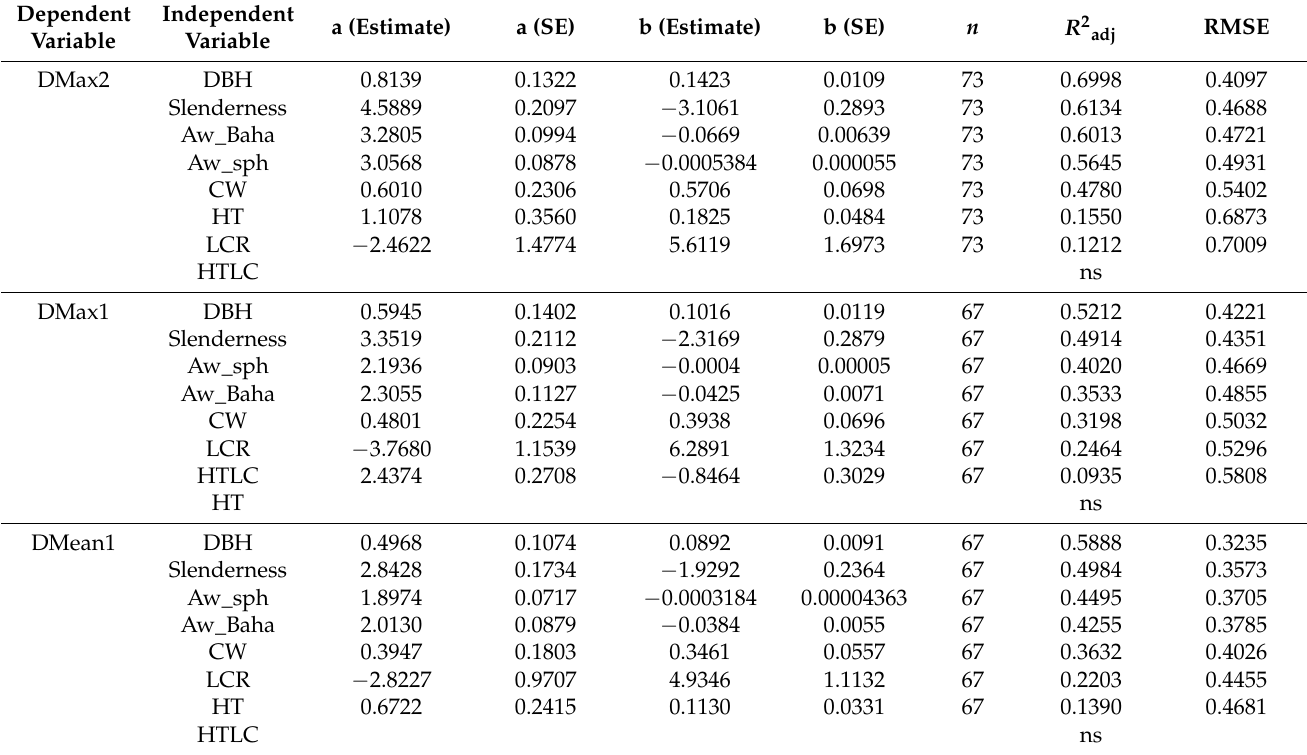
Table 8. Linear models describing variation in branch diameter. (DMax2 = maximum branch diameter in the lower 2 m section of the stem (cm); DMax1 = maximum live branch diameter in the whorl closest to 1 m (cm); DMean1 = average live branch diameter in the whorl closest to 1 m (cm); DBH = diameter at breast height (cm); Slenderness =